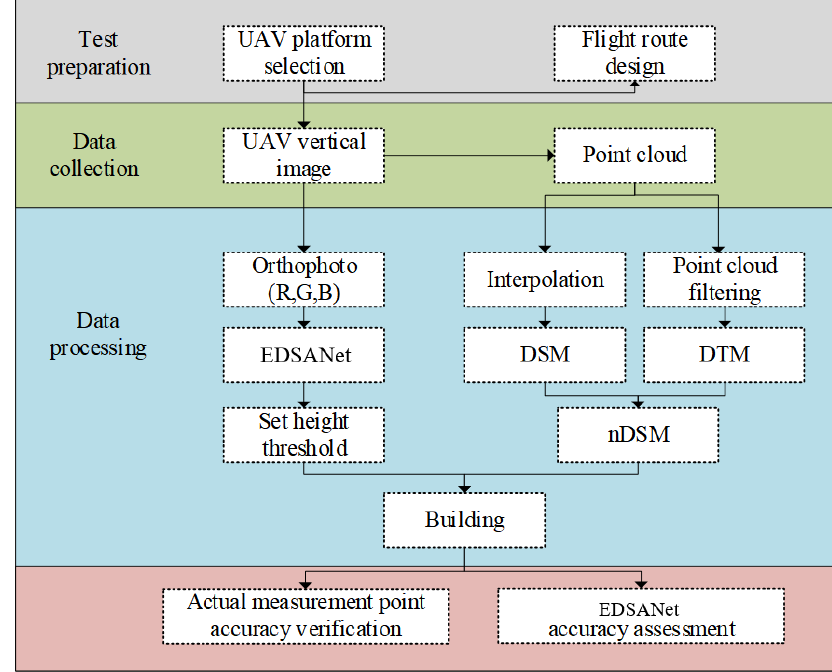
Figure 8. Flowchart of building height and floor area estimation.